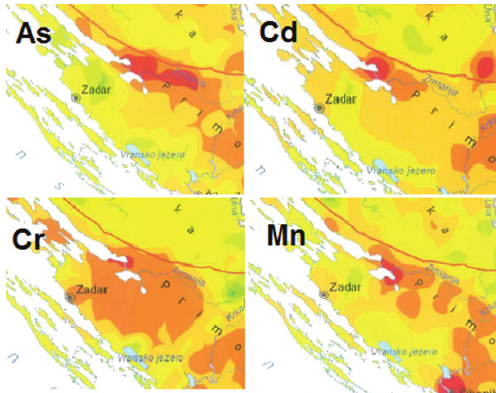
FIGURE 4. The load of arsenic, cadmium, chro- mium and manganese in the area of Zadar County